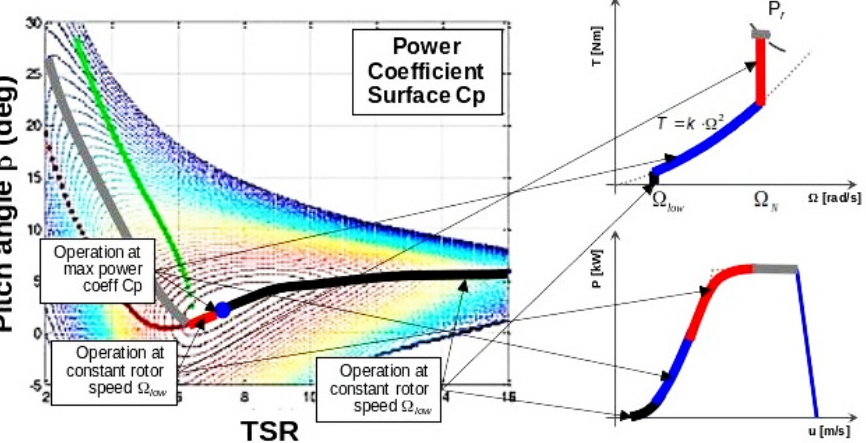
Figure 3. Power coefficient surface over the pitch angle β and Tip-Speed Ratio ( TSR ); torque demand T with rotor speed Ω ; and power